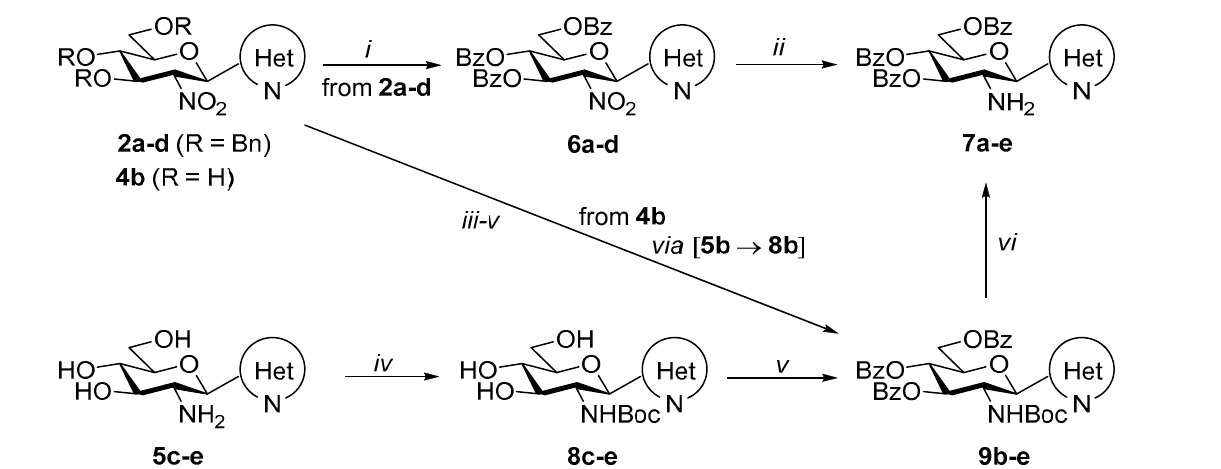
D -glucopyranosyl)azines. Table 3. Synthesis of C -(2 ′ -amino-2 ′ -deoxy-3 ′ ,4 ′ ,6 ′ -tri- O -benzoyl- β - D